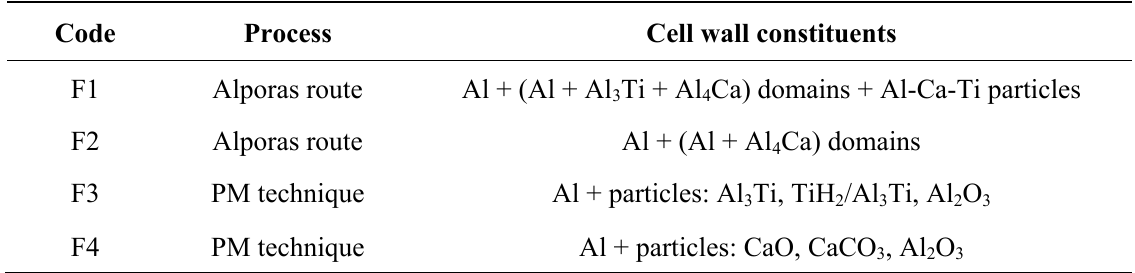
Table 1. Characteristic features of the cell wall material created in